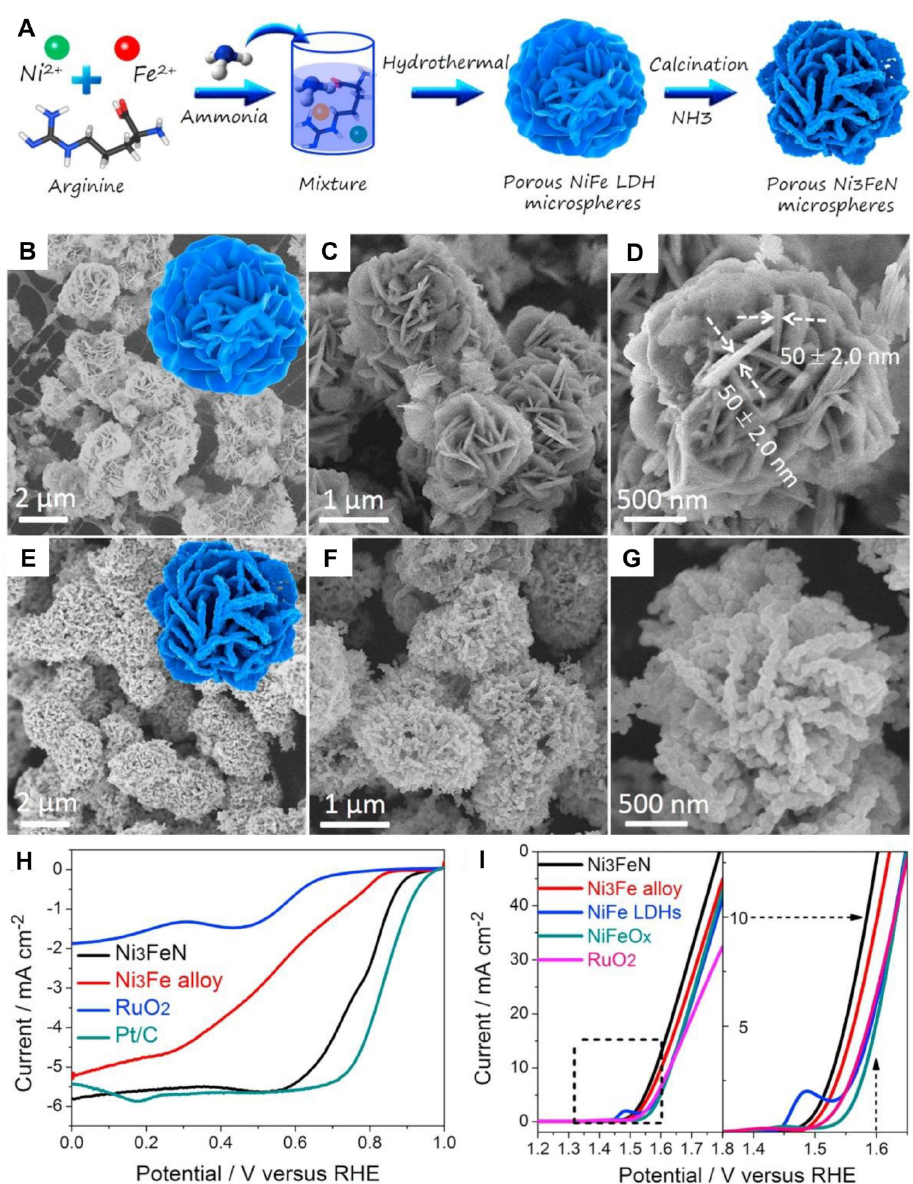
Figure 8. ( A ) Schematic of the formation of the porous Ni 3 FeN hierarchical microspheres; ( B – D ) SEM images of the NiFe LDH hierarchical microspheres; ( E – G ) SEM images of the porous Ni 3 FeN hierar- chical microspheres; ( H ) LSV curves in 0.1 M KOH electrolyte for ORR; ( I ) LSV curves in 0.1 M KOH electrolyte for OER. Reproduced with permission from [100]. Copyright © 2017